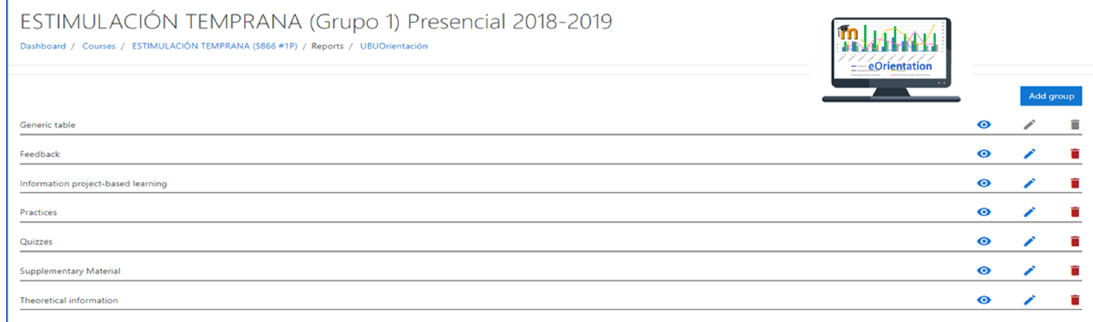
Figure 4. Classification functionality of the teaching elements in the “eOrientation” plugin.